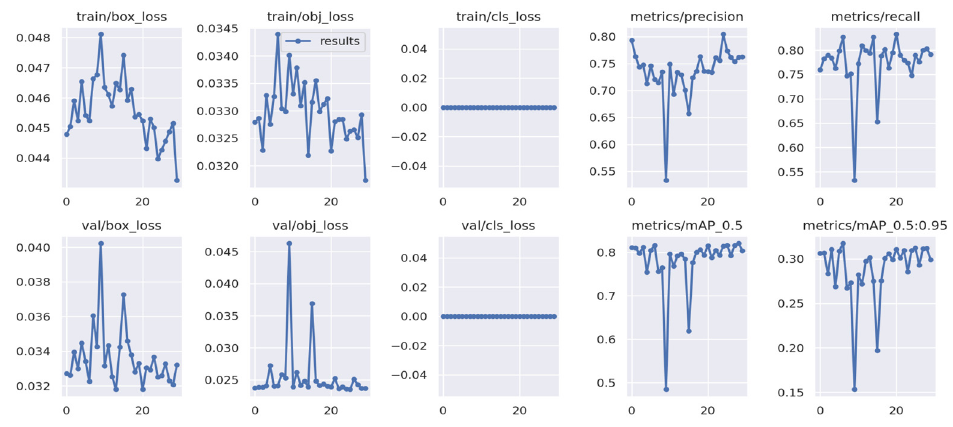
Figure 7. Results of YOLOv5 after 165 epochs. Table 4. Transfer learning parameters used for training the YOLOv5 model.